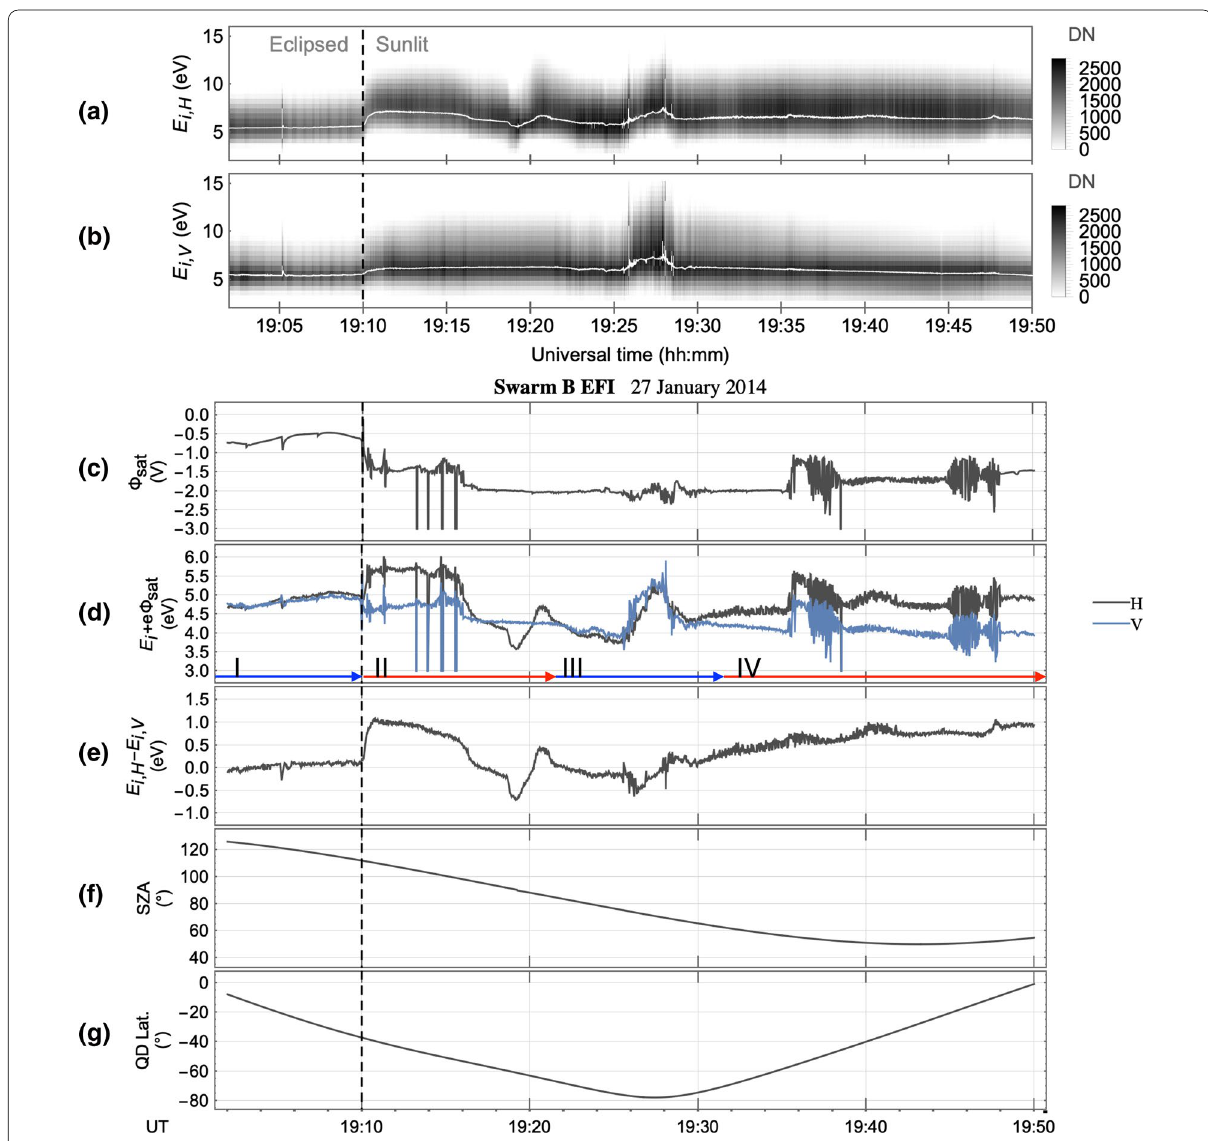
Fig. 6 Swarm B TII energy spectra for the horizontal sensor ( a ) and vertical sensor ( b ) on 27 January 2014. White lines show the 16 Hz first x -moments averaged to 2 Hz and converted to ion ram energy using Equation 4. Satellite floating potential estimated from the LP ( c ) is used to estimate the ion ram energies ( d ) beyond the electrostatic sheath as measured by the horizontal (black) and vertical (blue) sensors. The solar zenith angle at the satellite ( e ) is used to identify the period of eclipse, and the quasi-dipole magnetic latitude ( f ) illustrates the position and motion of the satellite in the southern